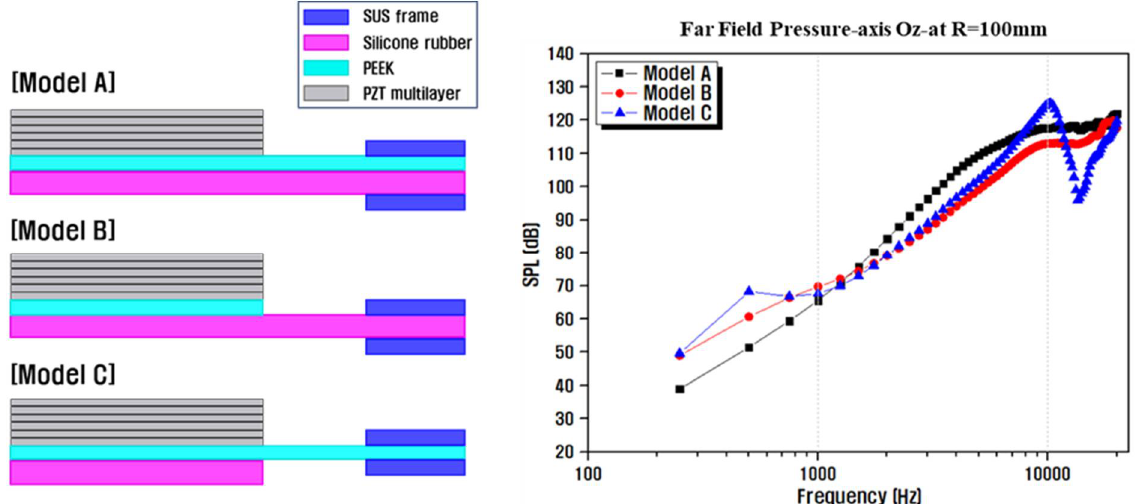
10 of 15 Figure 6. ( a ) Finite element model for the numerical analysis of the investigated piezoelectric speaker, and ( b ) the calcu- lated frequency response characteristics of the acoustic diaphragms of the piezoelectric speaker. Figure 7 shows the results of the simulation analyses performed using different di- mensions or structural designs of the two connected diaphragm types; the PEEK/silicon- rubber composite film used in the aforementioned FEA simulations was denoted as Model A. The smaller PEEK layer was attached to the center of the diaphragm in Model B, which exhibited more flexible characteristics than those of Model A, resulting in improved low- frequency SPLs [50]. In contrast, the Model C structure with a smaller silicon rubber film